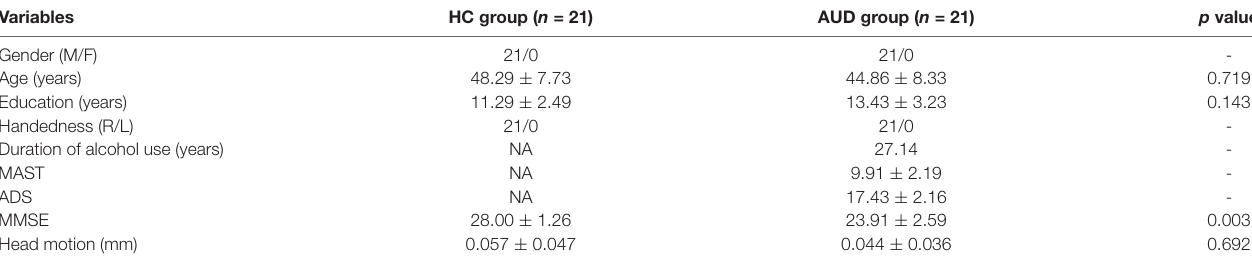
TABLE 1 | Demographics and clinical characteristics of patients in the HC group and AUD group.